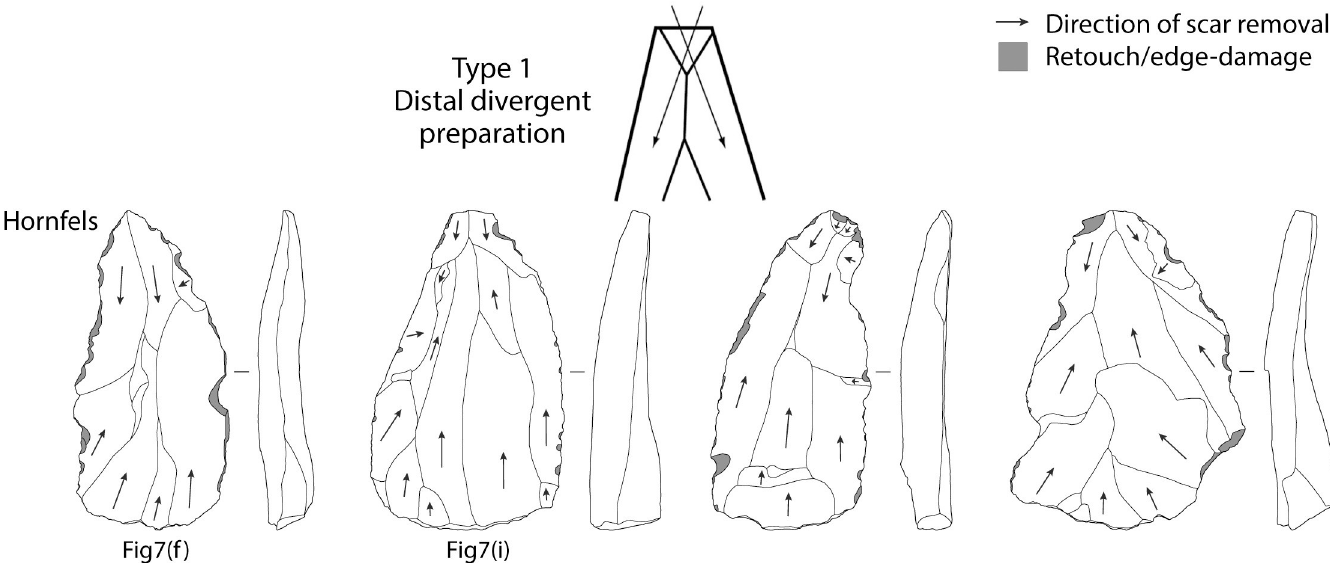
Fig 8. Diagrams of dorsal scar patterning on Tweefontein points related to Nubian Type 1 reduction. Points also illustrated in Fig 7 are indicated. Retouch and edge- damage scars are shaded in grey. Artefacts are not to scale.